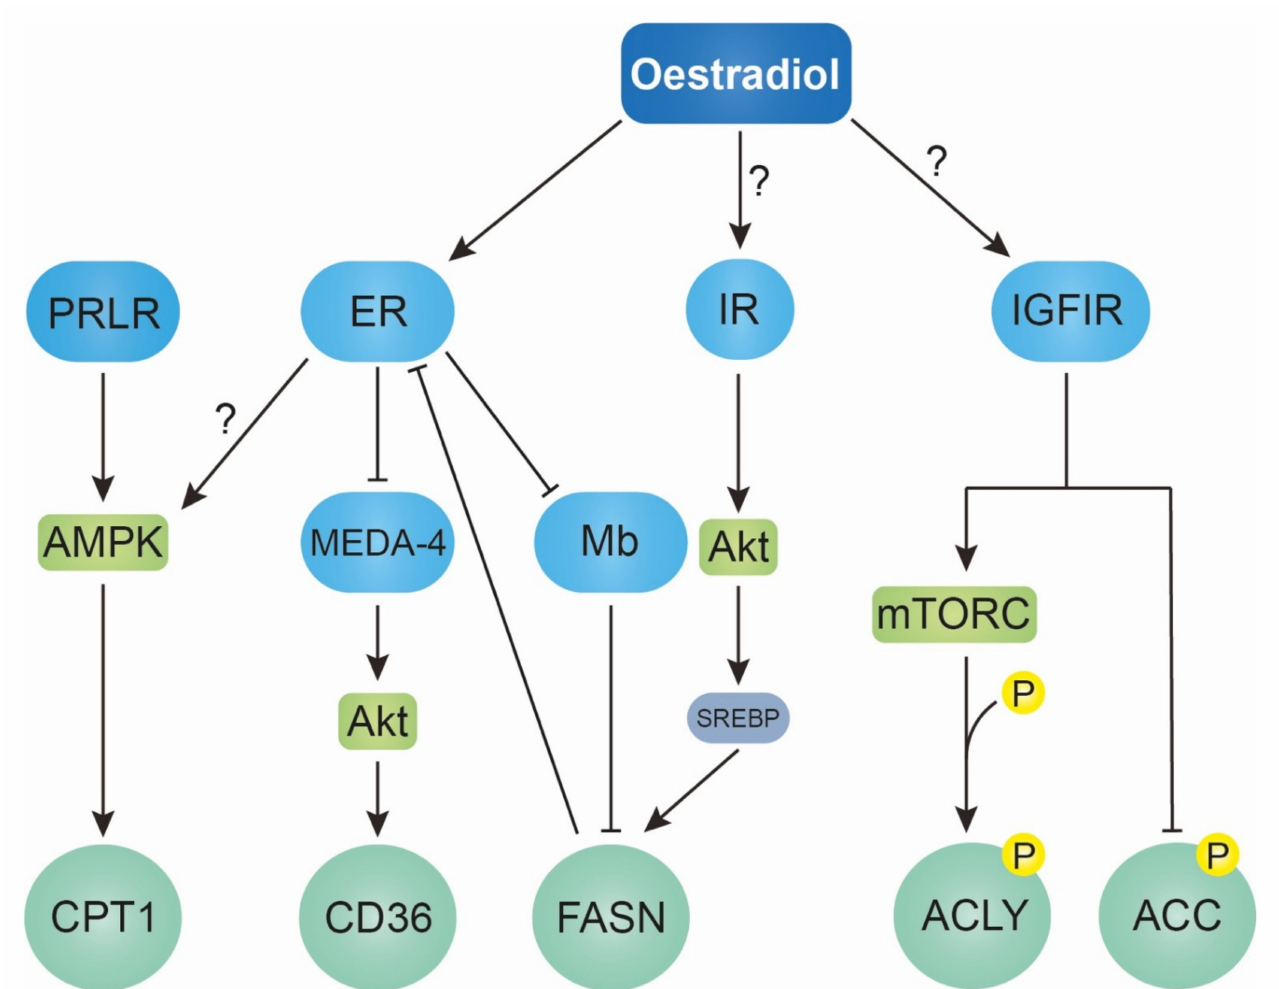
Figure 2. Oestradiol dysregulates the activity of FA metabolism enzymes in gynaecological cancers via the ER and possibly also the IGFIR and IR pathway. Solid lines with an arrowhead represent positive interaction whereas crossbars represent negative interaction. Question marks (?) represent interactions suggested indirectly by current evidence, but more direct evidence is needed to establish their existence. MEDA-4, Mesenteric oestrogen-dependent adipose 4, IGFI, Insulin-like growth